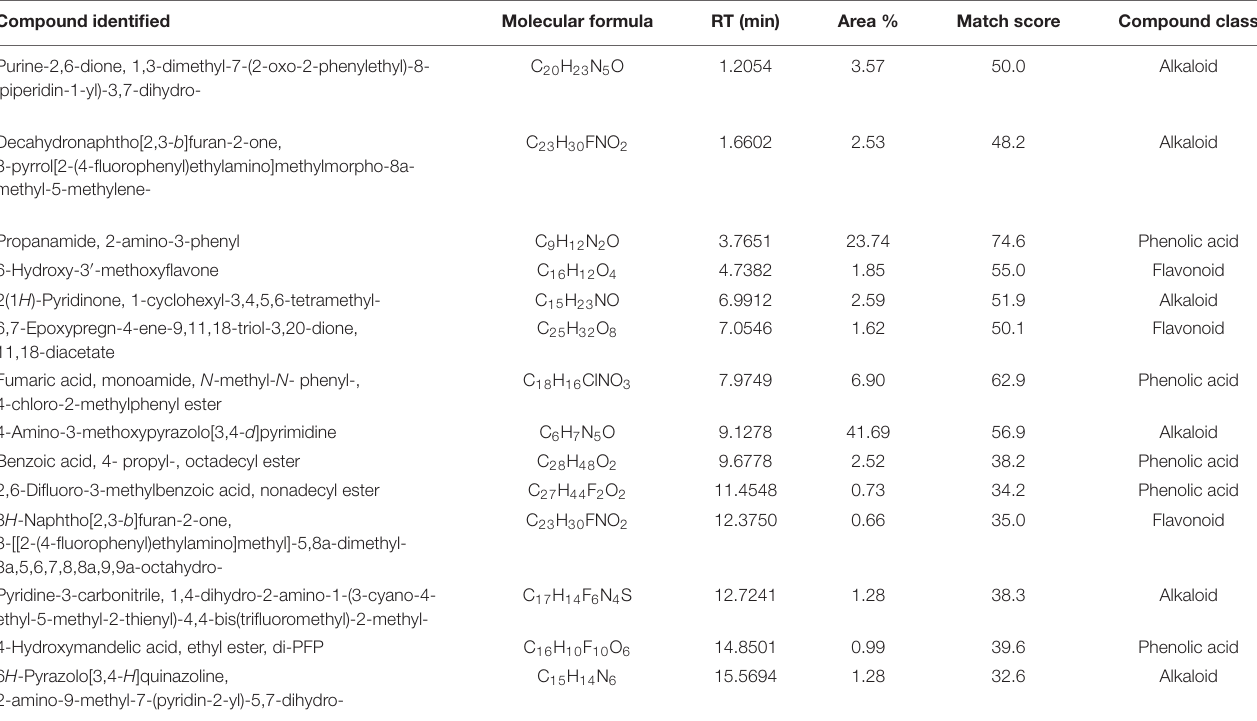
TABLE 3 | Most abundant compounds identified by LC-MS in castor extract.